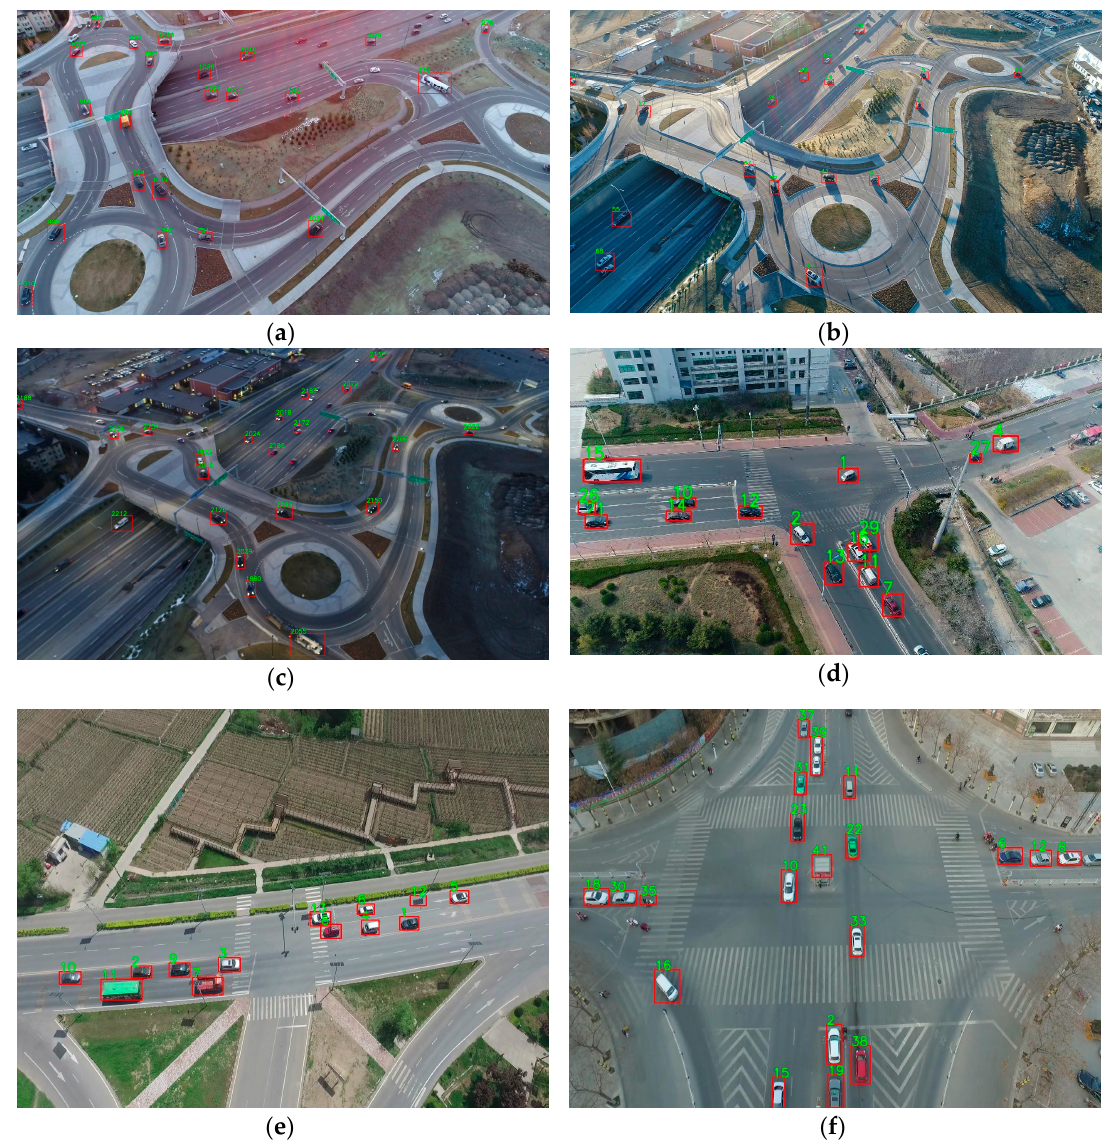
Figure 7. Testing videos: ( a ) DJI video 1 (DJI_0006) collected with a standard lighting condition; ( b ) DJI video 2 (DJI_0013) collected in late afternoons with long vehicle shadows; ( c ) DJI video 3 (DJI_0001) recorded in dawn with vehicle lights being on; ( d ) UAVDT-Benchmark dataset intersection (M0101); ( e ) Scene 2 of FHY-XD-UAV-DATA; ( f ) Scene 5 of FHY-XD-UAV-DATA.